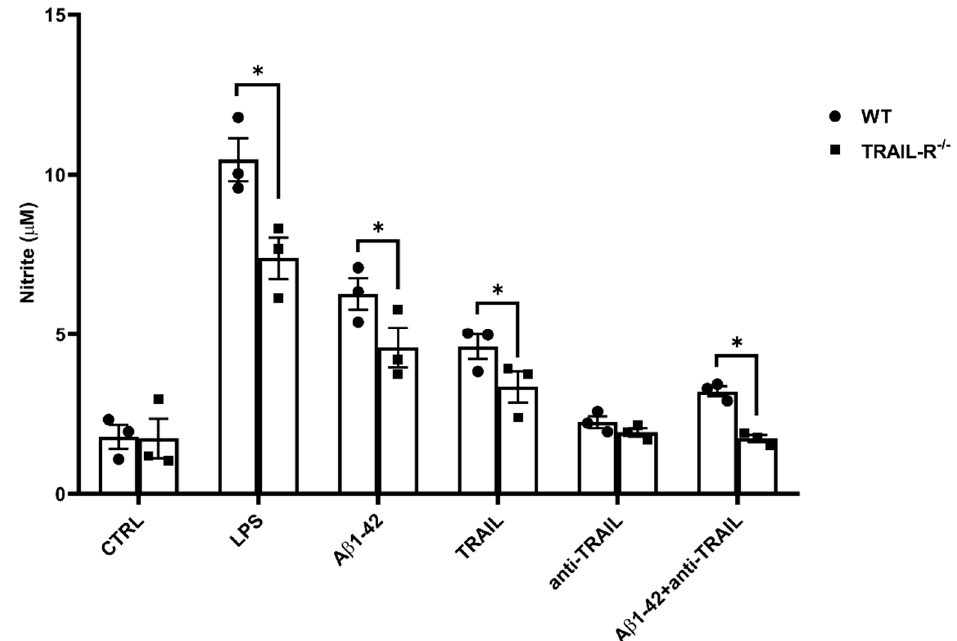
Figure 9. The lack of TRAIL-R2 is associated with a significant reduction of nitrite levels in the media of TRAIL-R − / − mouse primary hippocampal cells treated with A β 1-42. Nitrite levels in the media of embryonic hippocampal cells following 48 h treatment with LPS (10 µ g/mL; positive control), A β 1-42 (1 µ M), TRAIL (100 ng/mL), anti-TRAIL (1 µ g/mL) or A β 1-42 plus anti-TRAIL. Data are expressed as mean ± SEM. One-way ANOVA and the Bonferroni post-hoc test were used to determine statistical significance. * p < 0.05.